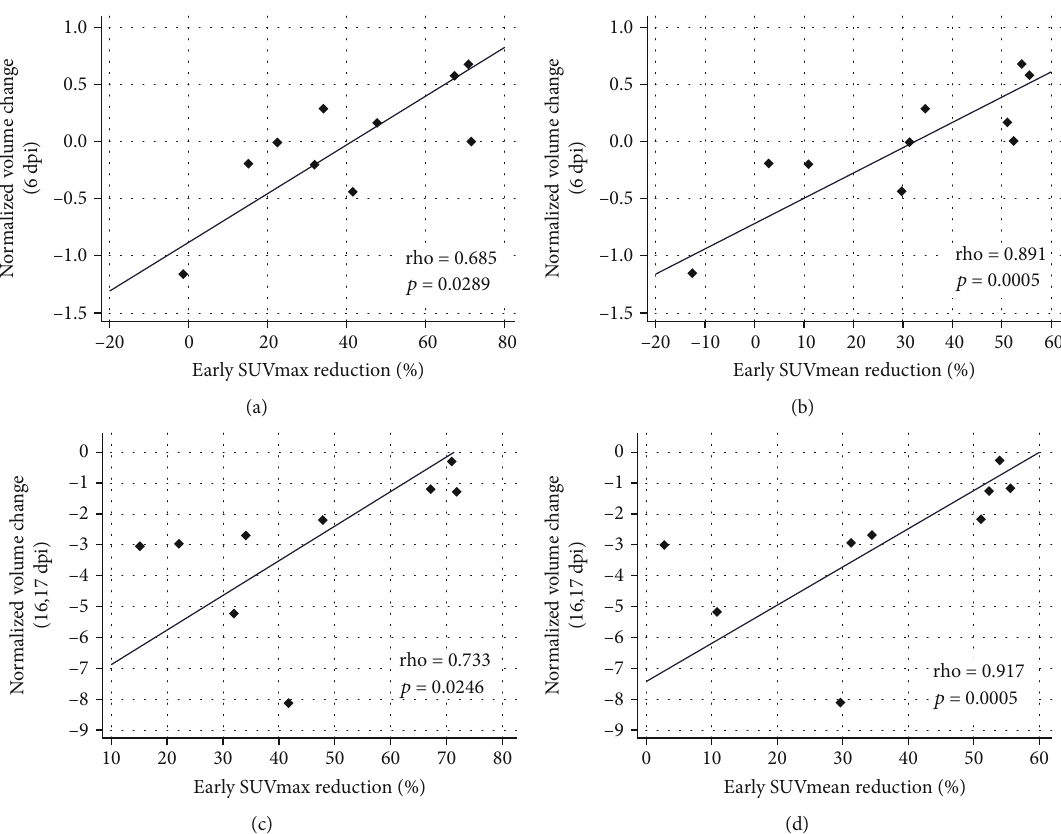
Figure 5: Correlations between treatment responses and early FDG uptake changes after bacterial cancer therapy (BCT) using engineered Salmonella typhimurium in a CT26 colon cancer cell line mouse model. Treatment responses were determined at two time points: early (6 dpi) and late (16 or 17 dpi). Normalized tumor volume change is calculated using tumorvolume ð 0dpi Þ − tumorvolume ð x dpi Þ /tumor volume ð 0dpi Þ . Early SUV reduction% was de fi ned as 100 × ð SUVat 0dpi − SUVat 1or 2dpi Þ /SUV at 0 dpi. A higher early SUV reduction% meant a larger decrease in FDG uptake after BCT (1 or 2 dpi). (a) Early SUVmax reduction% and normalized volume change at 6 dpi. (b) Early SUVmean reduction% and normalized volume change at 6 dpi. (c) Early SUVmax reduction% and